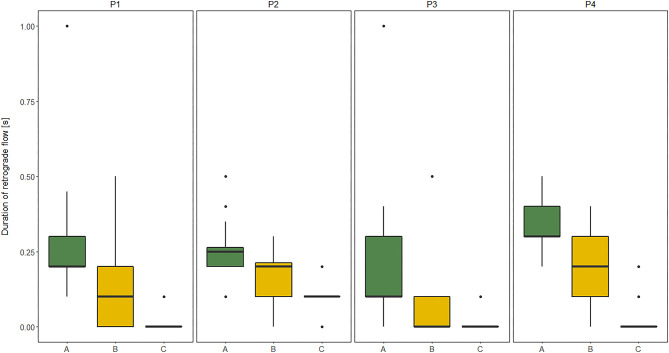
Comparisons between subgroup: A (high lumbar), B (low lumbar), and C (sacral) level of the spinal cord defect in relation to the duration of retrograde flow (RT) evaluated at four sites of Great saphenous vein (GSV): proximal thigh level (P1); medial thigh level (P2); upper leg level (P3); lower leg level (P4) of lower limbs (n = 60 each) measured in vertical position in children with myelomeningocele (MMC group). Kruskal–Wallis test for independent samples.